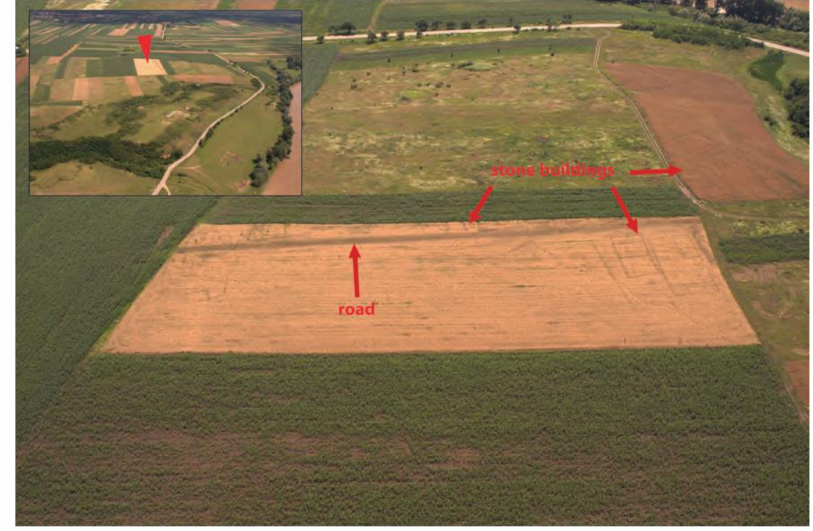
Figure 8. The road from the Cigm ă u fort to the baths in Geoagiu–B ă i ( © [97]). Fodor estimated the dimensions of the Roman fort from “Progadie” (the term means “cemetery” in the local dialect) at 140 × 40 fathoms (approximately 256 × 73 m) [78]. A few years later, Neigebaur mentioned a camp as well (with an earthen rampart and a deep defensive ditch), but on the “Turriak” plateau, measuring 2000 by a few hundred paces [78]. Before the start of systematic archaeological excavations, the presumed dimensions of the camp were 246.5 × 75.8 m [82,98,99]. It must be noted that at the middle of the 20th century the exact location of the fortification was still in debate and